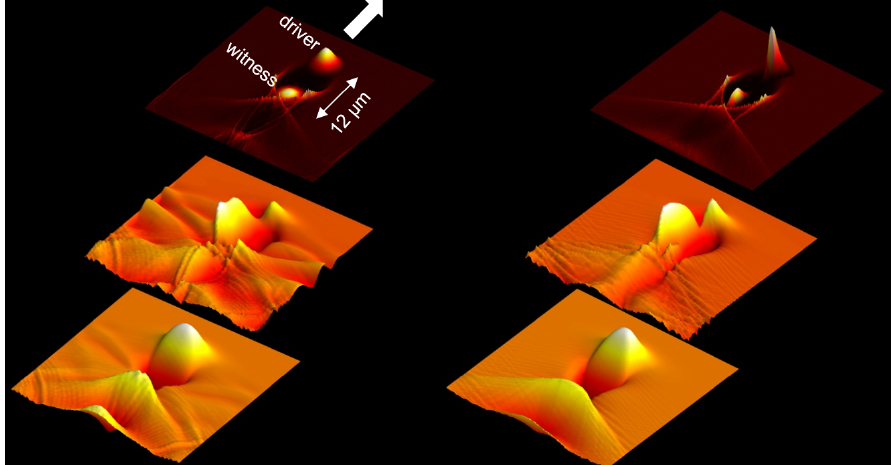
Figure 7. An electron double bunch from an LWFA stage is put into a second, higher density plasma stage, where it acts as a driver-witness pair PWFA energy afterburner. The right hand side shows a later snapshot during the PWFA acceleration, where plasma lensing has pinched both driver and witness bunch. The top plots shows the electron density, the middle plots the transverse electric field, and the bottom plots show the longitudinal wakefields. Visualization adapted from